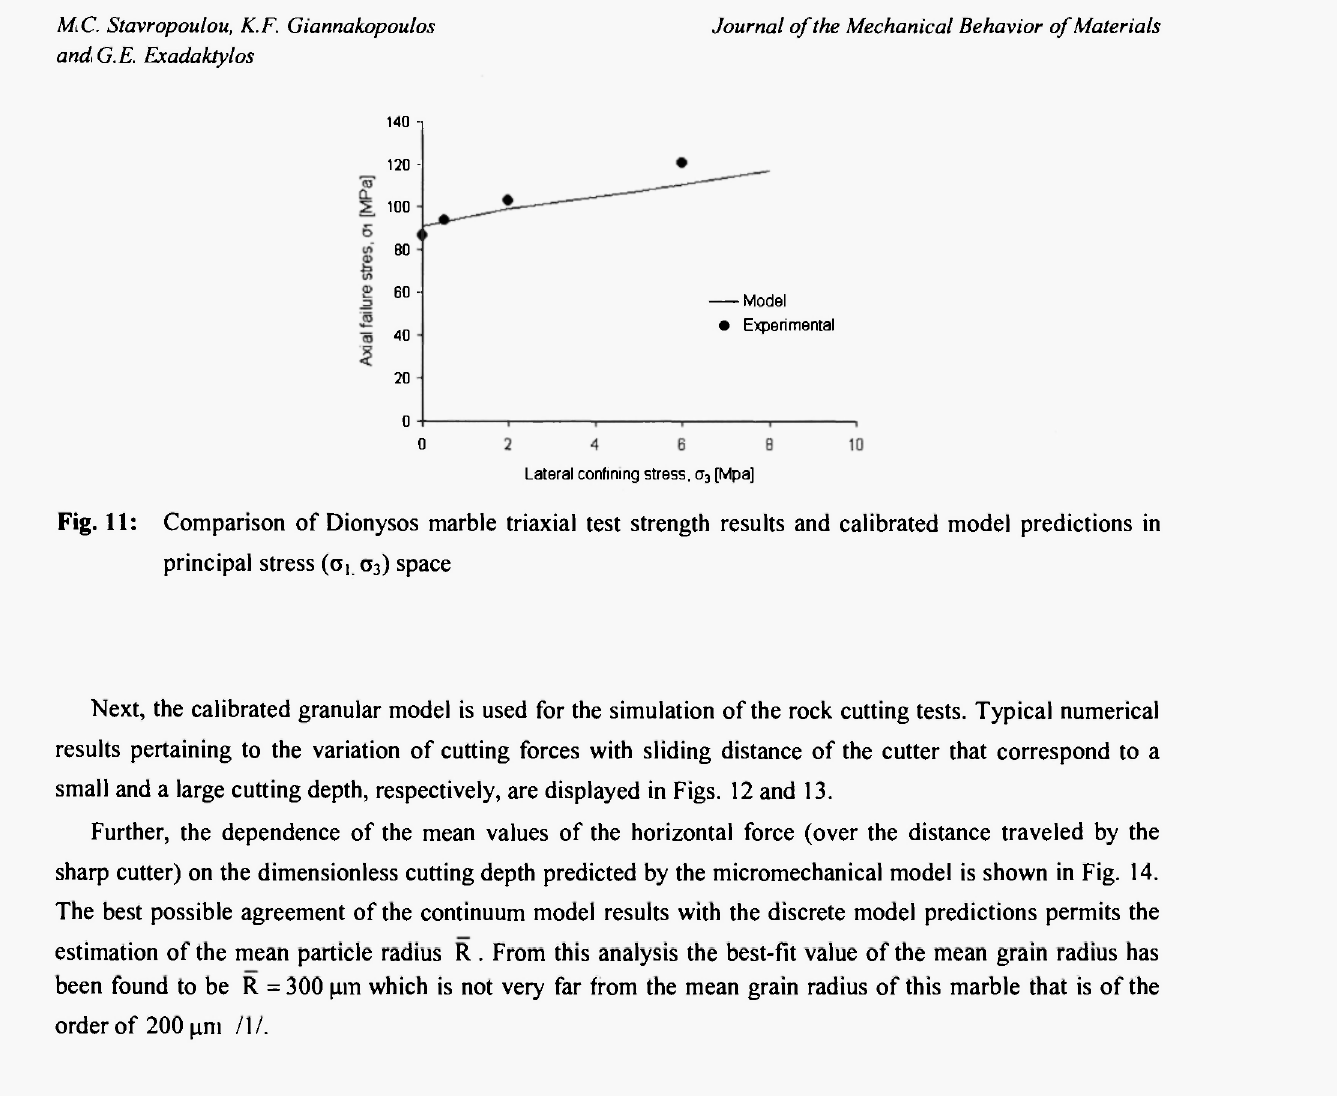
—- Model φ Experimental